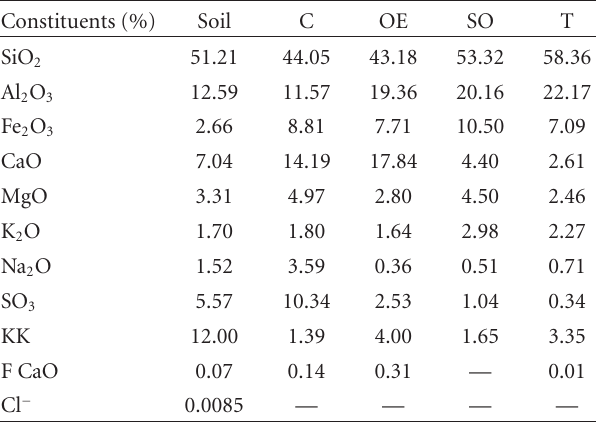
Table 1: The chemical composition (%w/w) of the materials used.